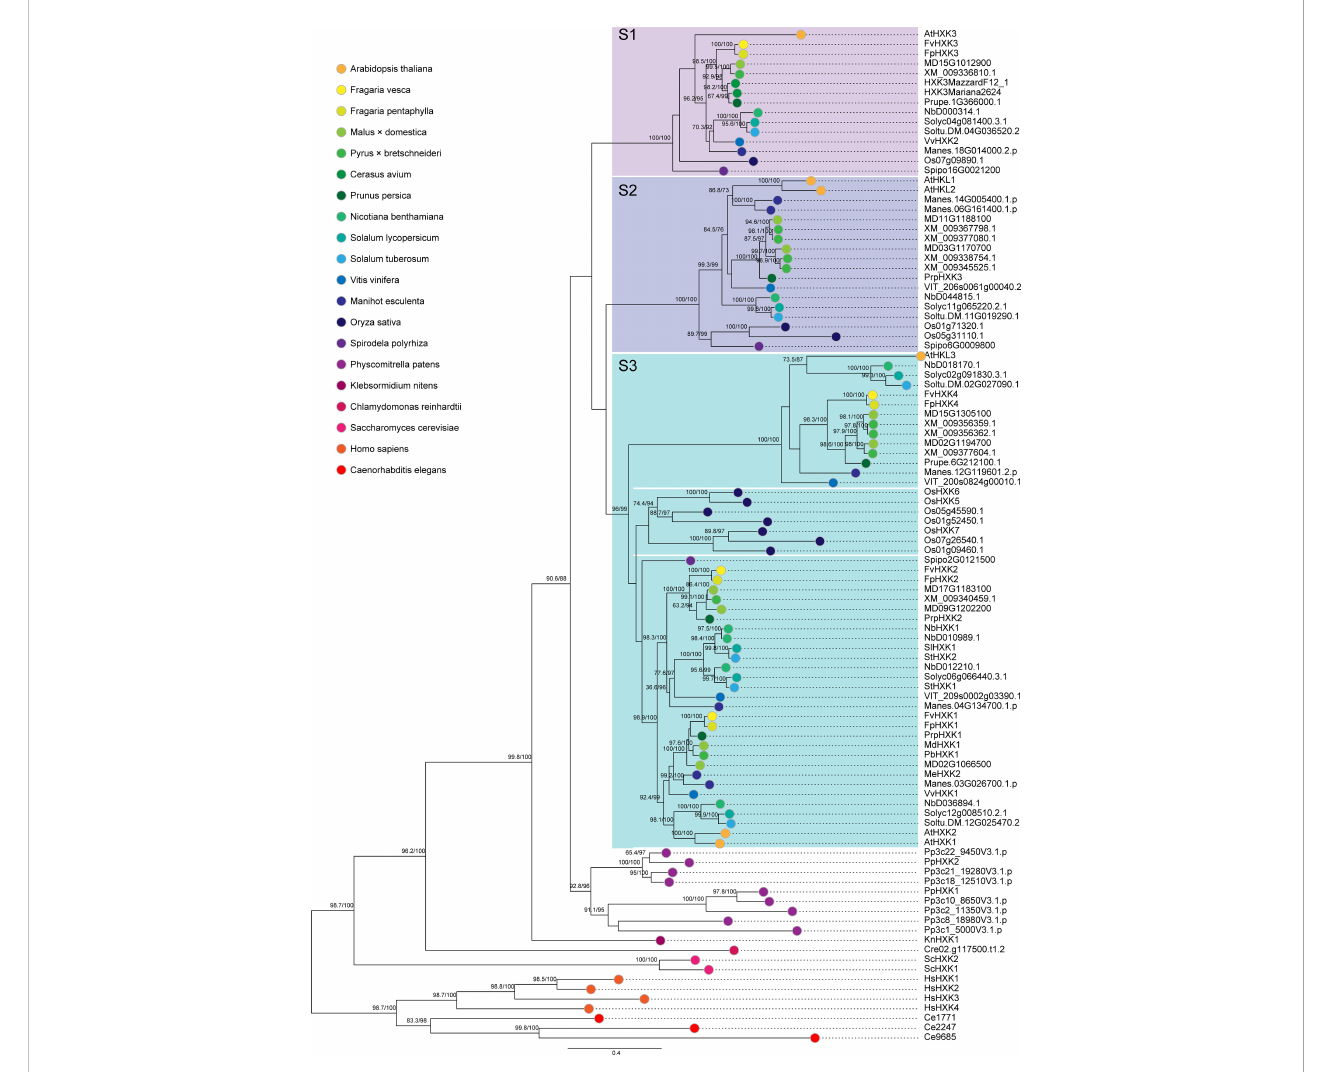
FIGURE 2 The maximum likelihood phylogenetic tree based on the identi fi ed HXK proteins. The phylogenetic tree was generated based on the JTT+I+G4 substitution model with 10000 fast bootstrap replicates. The accession number of the proteins could be found in the Supplementary Table